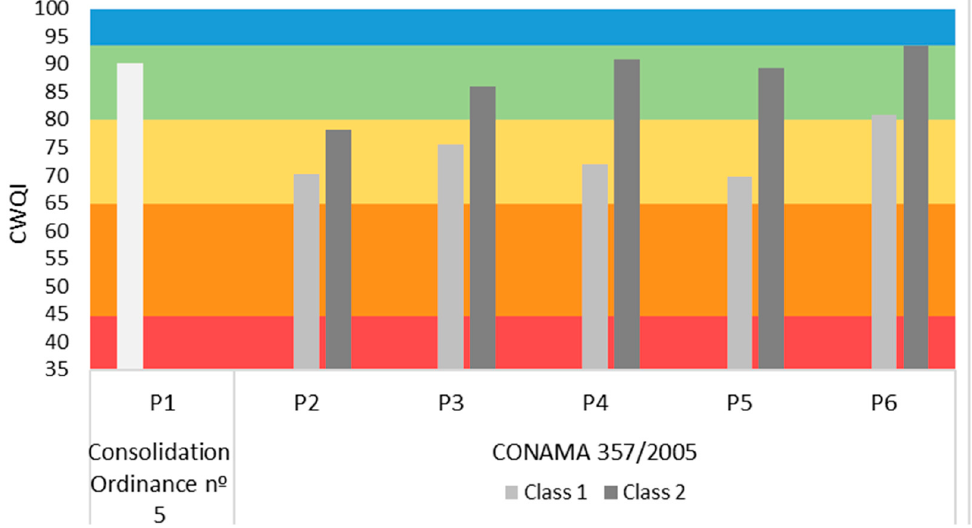
Figure 3. Water quality indices for Buritis Lake, encompassing results for rainy and drought sea-